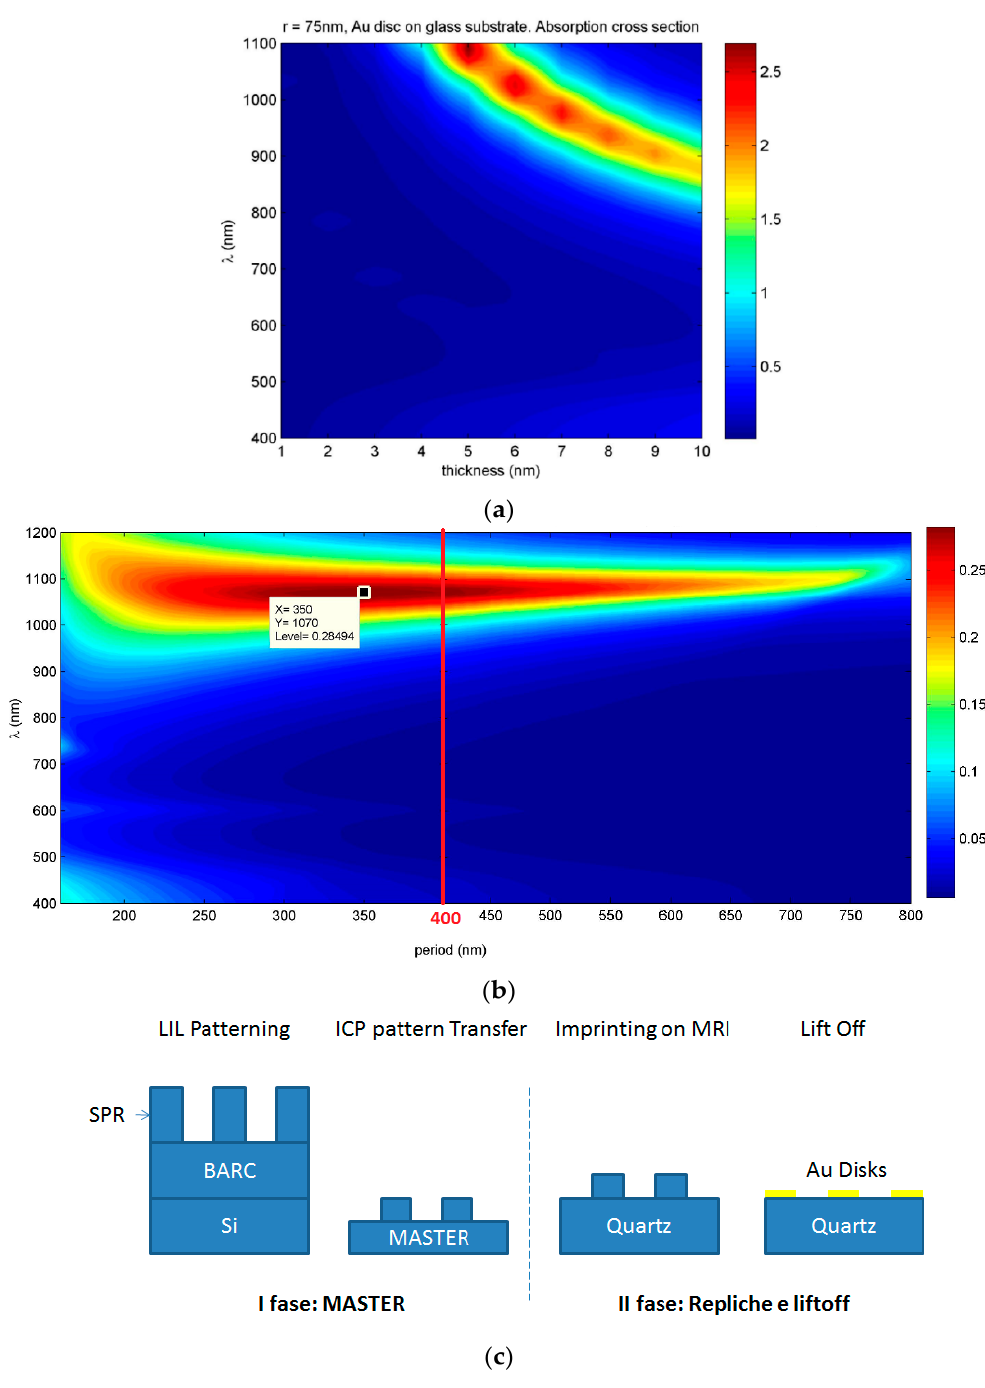
Figure 1. ( a ) Absorption cross-section of single Au ND as a function of wavelength and ND thickness for radius = 75 nm; ( b ) Absorption cross section of Au NDs array as a function of wavelength and periodicity for radius = 75 nm, thickness = 5 nm; ( c ) Scheme of sample preparation method.